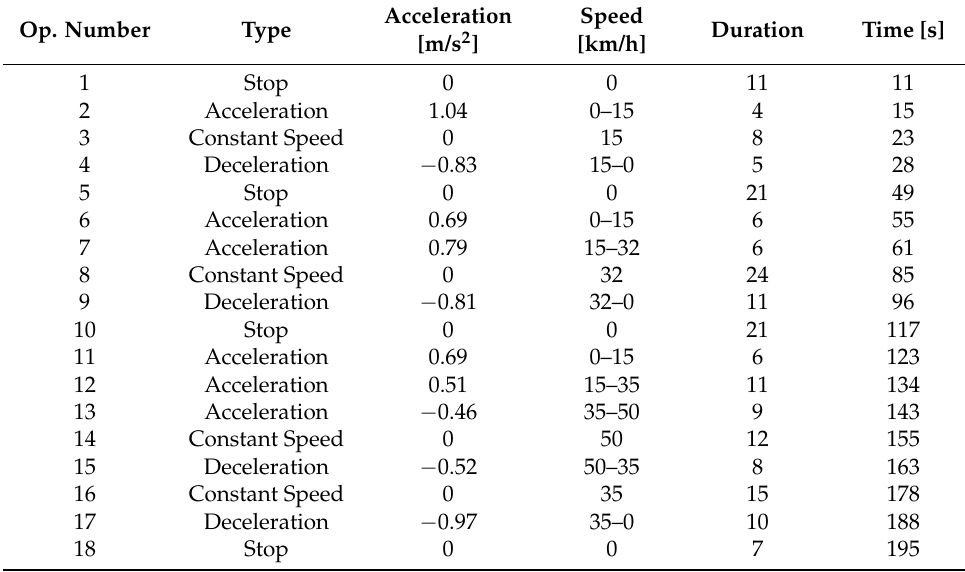
Table 1. Operations of the elementary urban cycle [30]. Op.